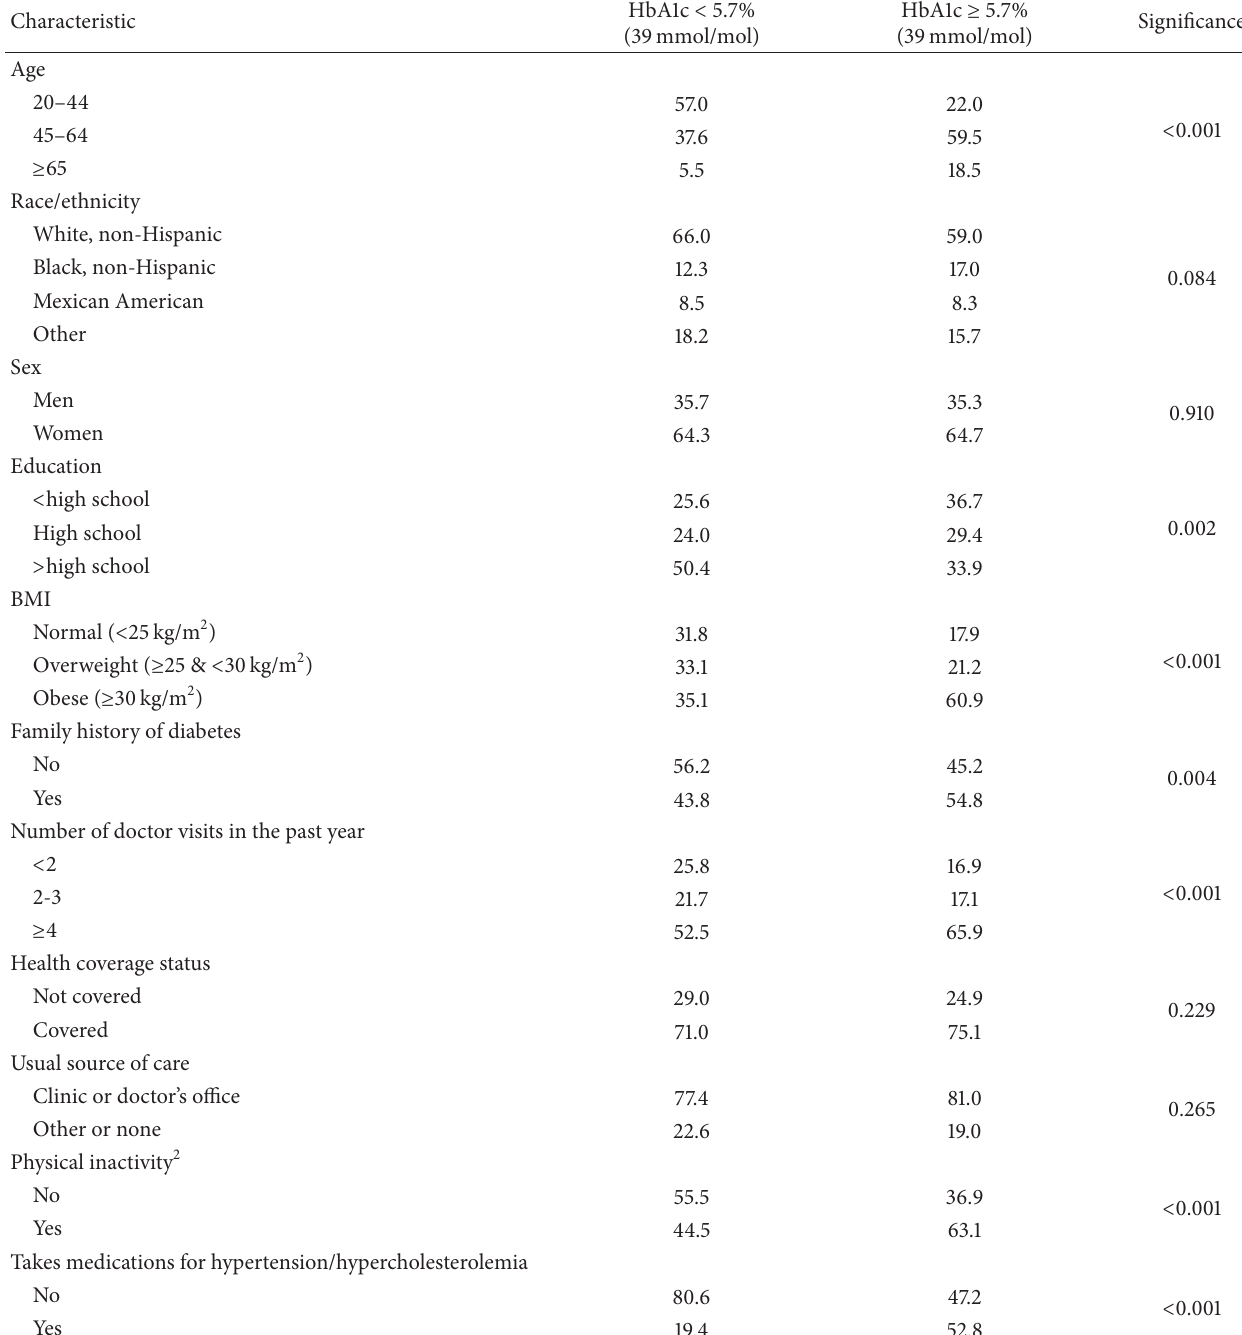
Table 1: Characteristics of nonpregnant persons ≥ 20 years of age according to HbA1c values in the prediabetes/diabetes ranges (in %) 1 .